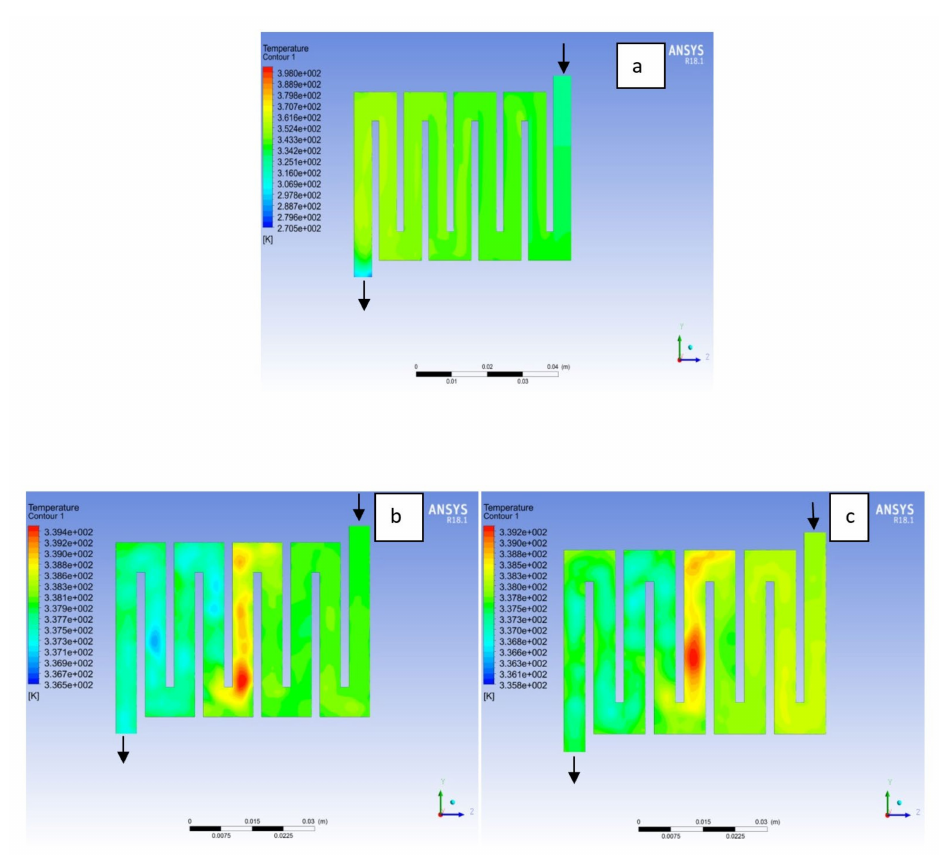
Figure 9. Temperature distribution at the cathode region (GDL/CL) for each material at 338K: ( a ) Aluminum, ( b ) Copper, ( c )